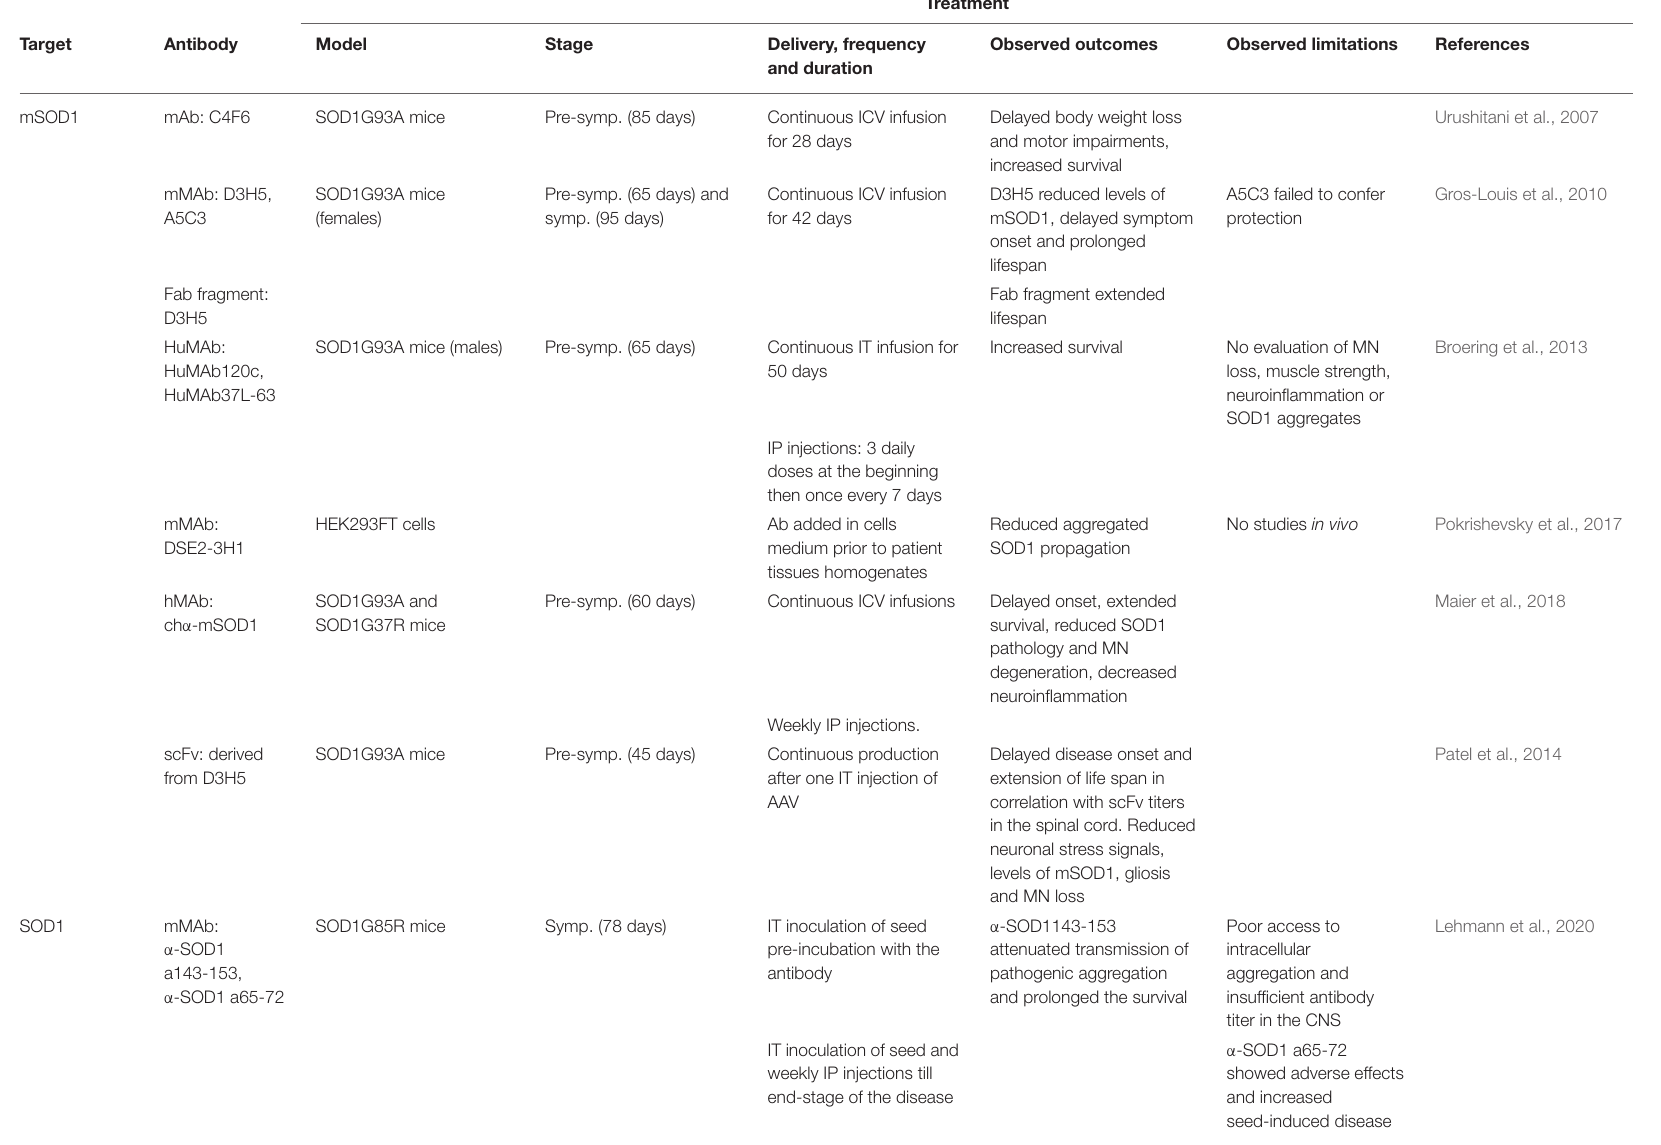
TABLE 2 | Summary of the main characteristics of treatments tested in the 31 original articles analyzed in this